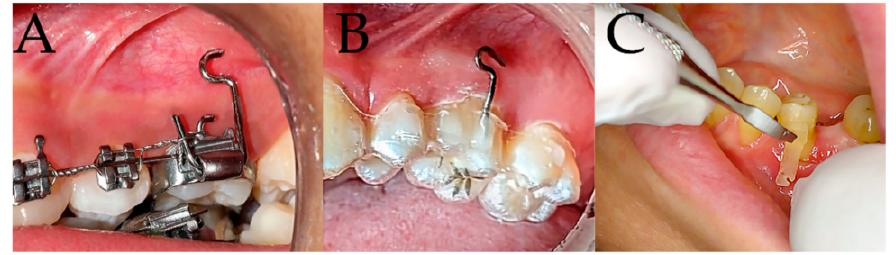
Figure 3. Examples of customized power-arms ( A ) on vestibular fixed appliance, ( B ) with clear aligner therapy, ( C ) first 3D printed power-arm 2018